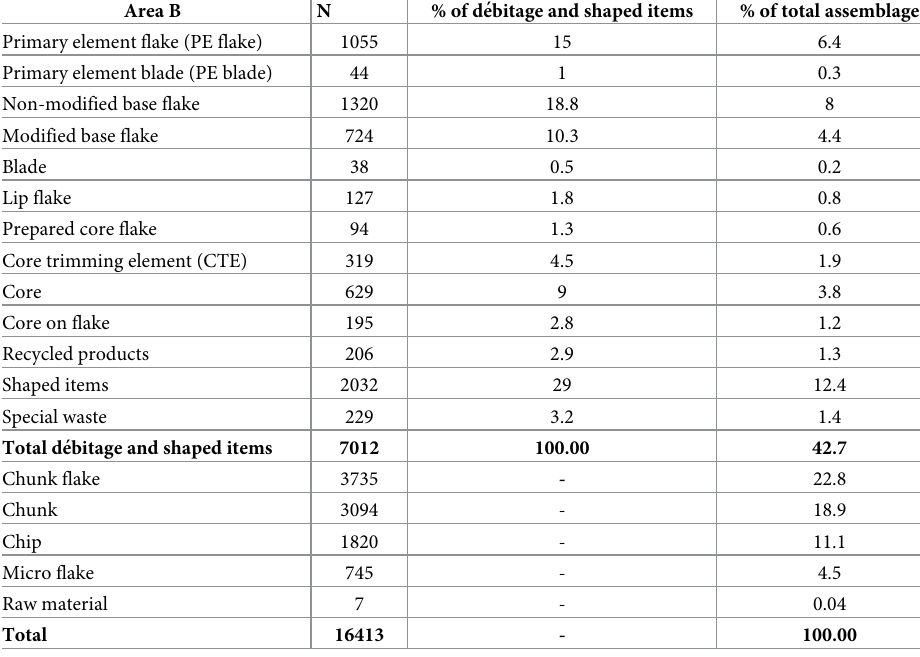
Table 7. General breakdown of the flint assemblage from Jaljulia, Area